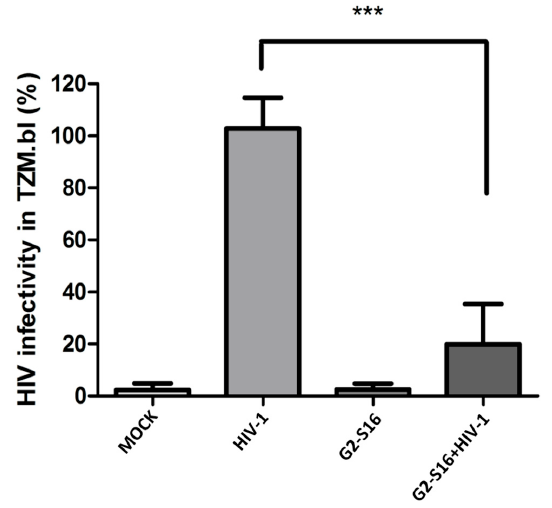
Figure 5. G2-S16 inhibits infection of T cells from infected MDMs. MDMs treated with G2-S16 and infected with 6 ng/µL of HIV-1 per 1 × 10 6 cells for 2 h were co-cultured with isolated T cells for 48 h. After incubation, T CD4 cells were isolated and HIV-1 infectivity was titrated by infection of TZM.bl. Mock cells were used as the non-treated control. The mean values (mean ± SD) of three independent experiments are shown (*** p < 0.001).